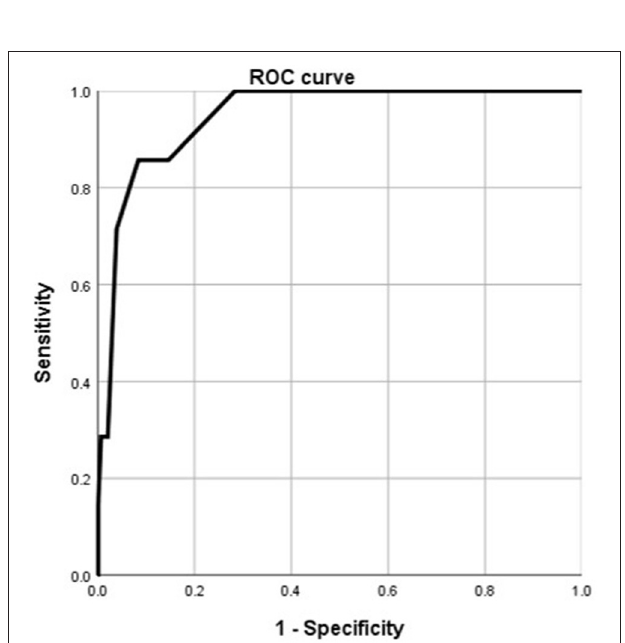
FIGURE 9 | Using number of comorbidities for discriminating the dead cases from the surviving patients ( n = 718; survival and dead groups, n = 710 and 8, respectively). ROC analysis showing the performance of number of comorbidities in distinguishing the dead cases from the surviving patients. ROC, receiver operating characteristic curve; AUC, area under the